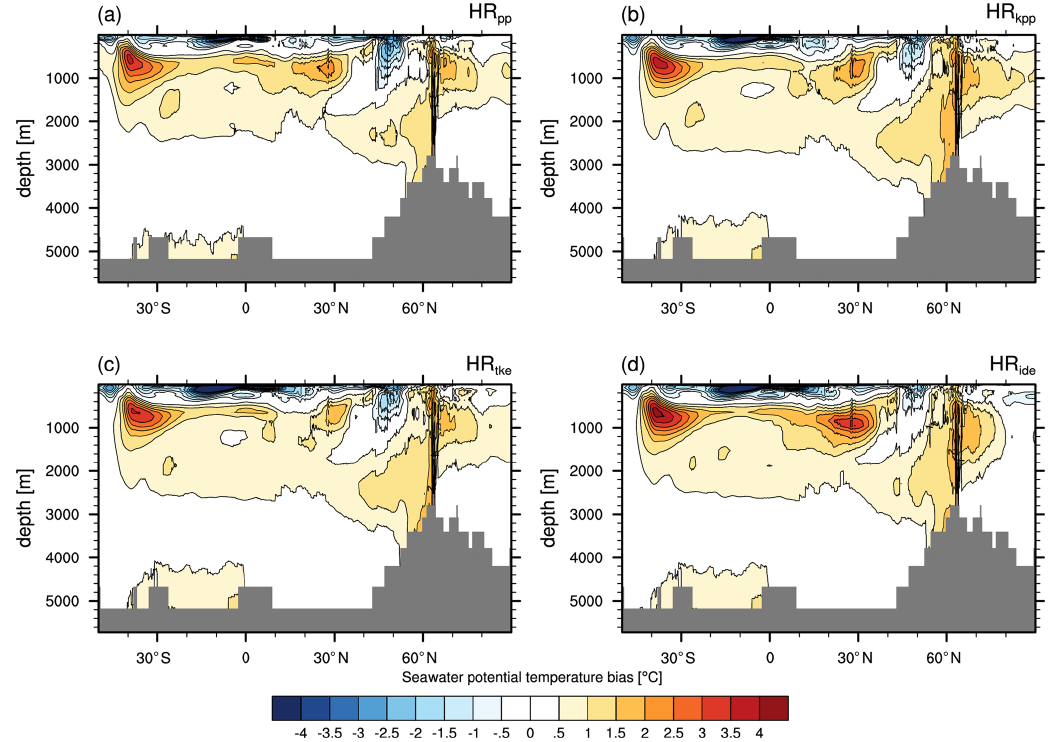
Figure 9. Zonal-mean potential temperature bias of MPI-ESM1.2-HR minus EN4 (1945–1955) in the Atlantic and Arctic Ocean for (a) HR pp , (b) HR kpp , (c) HR tke , and (d) HR ide . Table 2. Time-averaged volume transport (1Sv = 10 6 m 3 s − 1 ) of Denmark Strait overflow water (DSOW), Faroe Bank Channel (FBC), and Faroe–Shetland Channel (FSC) overflow from simulations with MPI-ESM1.2-HR. Hansen et al. (2017) note that measurements by Rossby and Flagg (2012) and Childers et al. (2014) include a closed circulation on the Faroe Shelf (0.6Sv) and flow on the Scottish Shelf, which are not included in measurements by Berx et al. (2013) and Hansen et al. (2015). A standard deviation based on annual averages is given for the simulations.